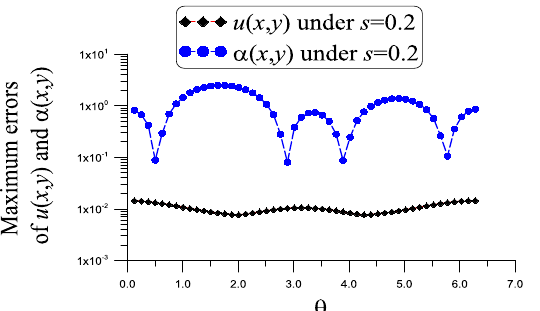
Figure 3. For example 2, showing the errors in the numerical recovery of u and α under a noise s = 0.2 with Q = u 2 + sin u